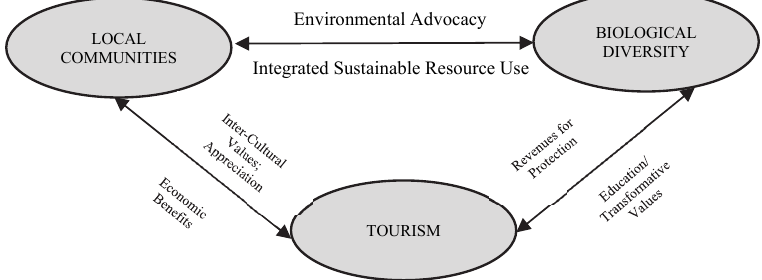
Fig. 1. Successful Ecotourism Paradigm (Ross & Wall,